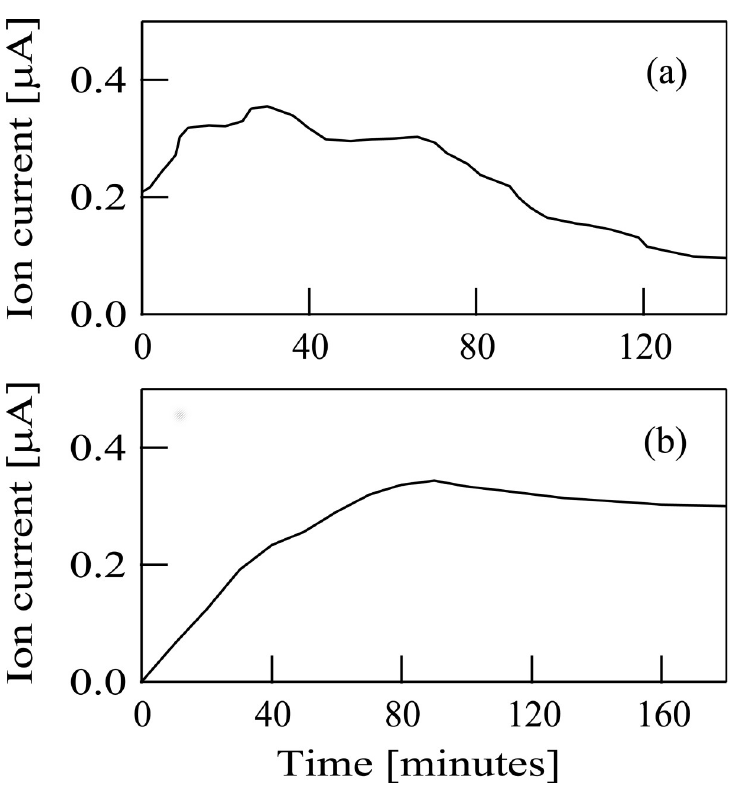
Fig 5. (a) The typical time course evolution of the Sn + ion current when tetramethyltin was used as the source material. (b) The typical time course evolution of the Sn + ion current when a tin oxide target was set inside the modified Freeman-type ion source. The vertical and horizontal axes in both figures (a and b) represent the ion current and the duration of the experiment respectively.